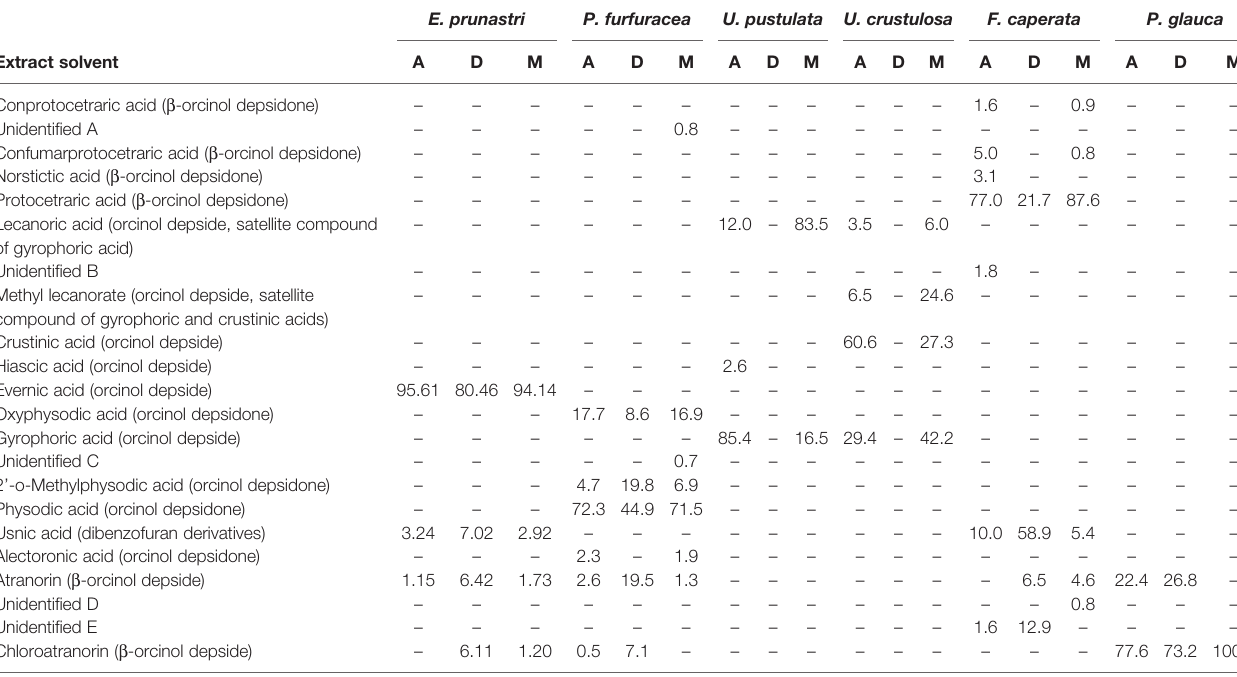
TABLE 2 | Summary of the UV-absorbing natural compounds identi fi ed in the lichen extracts by high performance liquid chromatography